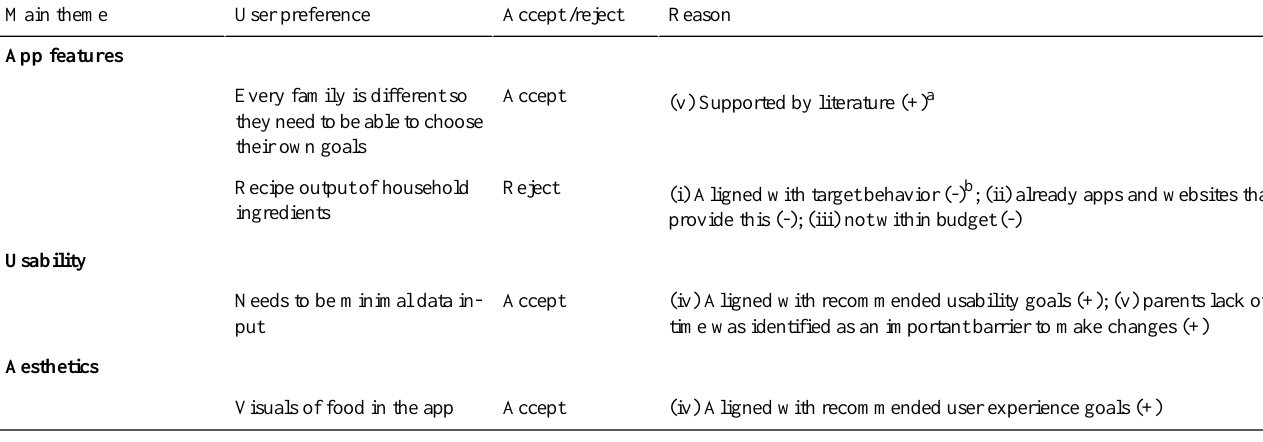
Table 2. Excerpt of decisions for rejecting or accepting user preferences.